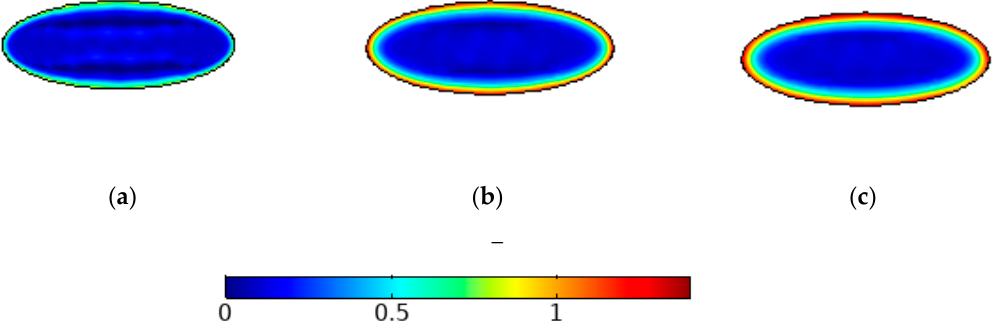
Figure 2. Temperature distribution (°C) in the water dispersion of sand–seed system when freezing the seed capsule at times 120 s ( a ), 240 s ( b ), 300 s ( c ) for a seed with a length of 4 mm, a thickness of 1.5 mm.